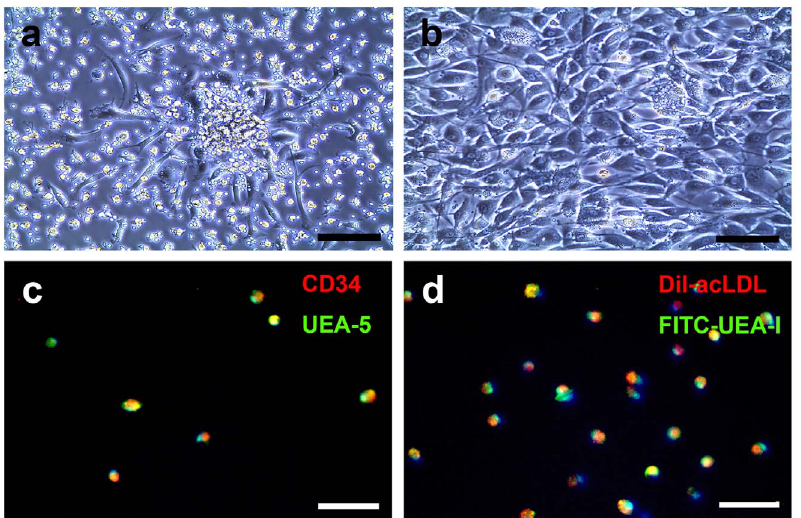
Figure 2. BM-EPC culture and identification. A . Photomicrographs showing that after 5 days of culturing, BM-EPC isolated from rat bone marrow, displayed spindle-like attached cells and formed colonies ( a ), Bar=140 m m. Higher magnification showed that these cells performed endothelial cell morphology ( b ), Bar=140 m m. B . Putative BM-EPCs were stem cell marker CD34 + (red color) and were able to take in Ulex europeus agglutinin-5 (green color. c ). They also were DiI-acLDL + (red color) and fluorescein isothiocyanate-Ulex europeus agglutinin-1 + (green color), which were (d) co-localized in . 95% cells, Bar=100 m m.